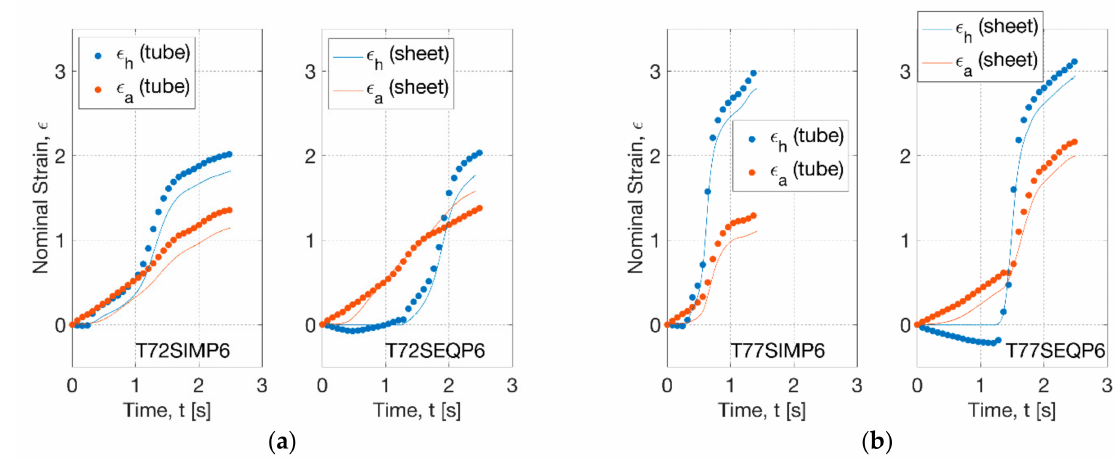
Figure 4. Strain history of tubes under blowing test and sheets under replicative biaxial test: ( a ) 72 ◦ C, ( b ) 77 ◦ C.